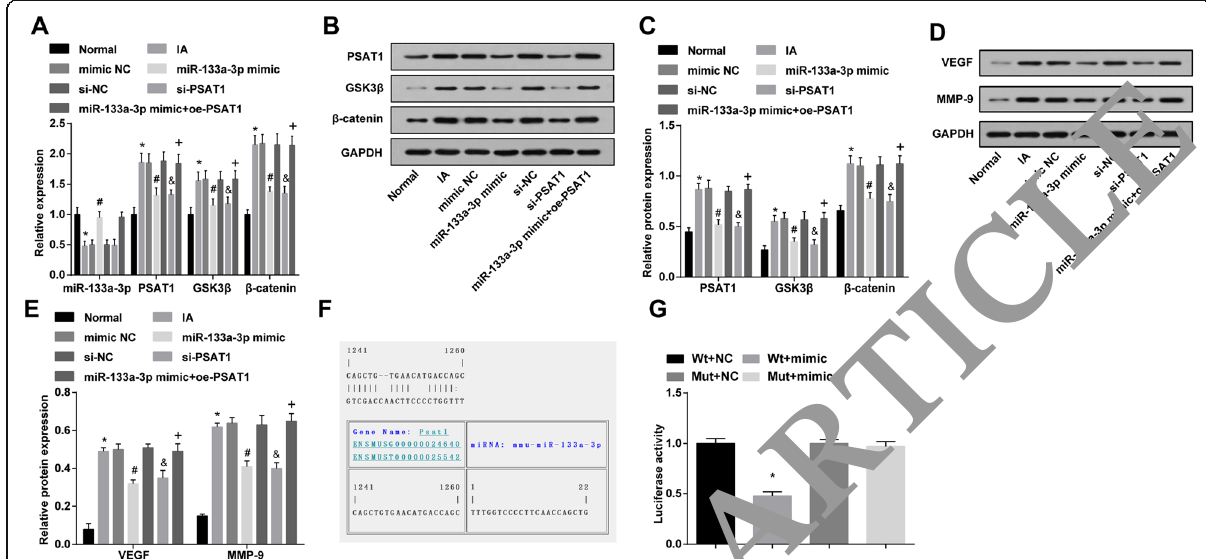
Fig. 7 Overexpression of miR-133a-3p and low expression of PSAT1 decrease PSAT1, GSK3 β , and β -catenin, VEGF and MMP-9 expression in IA tissues in vivo and PSAT1 is a target gene of miR-133a-3p. a Detection of miR-133a-3p, PSAT1, GSK3 β , and β -catenin expression in IA tissues of rats in each group by RT-qPCR. b Protein bands of PSAT1, GSK3 β , and β -catenin. c Detection of PSAT1, GSK3 β , and β -catenin protein expression in IA tissues of rats in each group by western blot analysis. d Protein bands of VEGF and MMP-9. e Detection of VEGF and MMP-9 protein expression in IA tissues of rats in each group by western blot analysis. f Prediction of the target site of PSAT1 binding to the corresponding miR- 133a-3p by Target Scan. g Result of dual luciferase reporter gene assay. a – e , n = 12; f – g , N = 3, * P < 0.05 vs. the normal group/the Wt + NC group. # P < 0.05 vs. the mimic NC group. & P < 0.05 vs. the si-NC group. + P < 0.05 vs. the miR-133a-3p mimic group. Measurement data were depicted as mean ± standard deviation, and data were assessed by one-way analysis of variance followed by Tukey ’ s post hoc